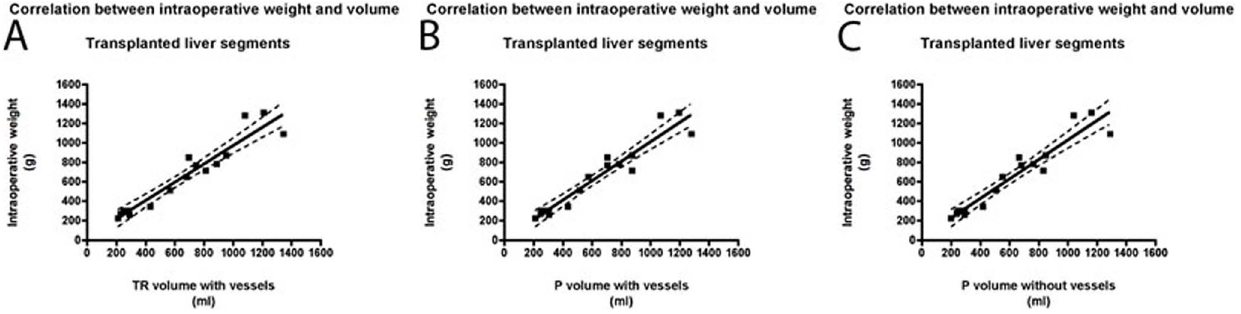
Figure 2. Linear Regression Analysis between Intraoperative Weights and Volumes of Transplanted Liver Segments. A For the manual commercial software (TR) with vessels, the regression equation was y=0.94x + 30.1 (R 2 =0.92; P , 0.001). B For the semi-automated interactive software (P) with vessels, the regression equation was y=1.00x + 12.0 (R 2 =0.92; P , 0.001). C For semi-automated interactive software (P) without vessels, the regression equation was y=1.01x + 28.0 (R 2 =0.92; P , 0.001). Note: dotted curves mark the 95% confidence bands; linear regression analysis demonstrated a strong linear relationship between intraoperative weights and volumes with comparable results between the 3 different techniques.